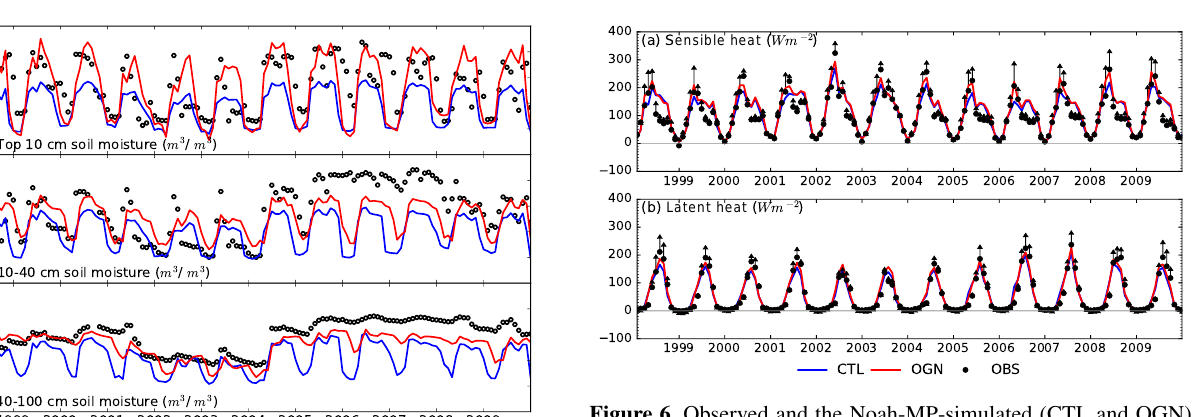
Figure 6. Observed and the Noah-MP-simulated (CTL and OGN) daytime monthly average sensible and latent heat flux above the canopy. Error bars represent the average and deviations [(RN − G ) × B/ (1 + B ) for SH, and (RN − G ) / (1 + B ) for LH] from observations, and B is the Bowen ratio ( B = SH /